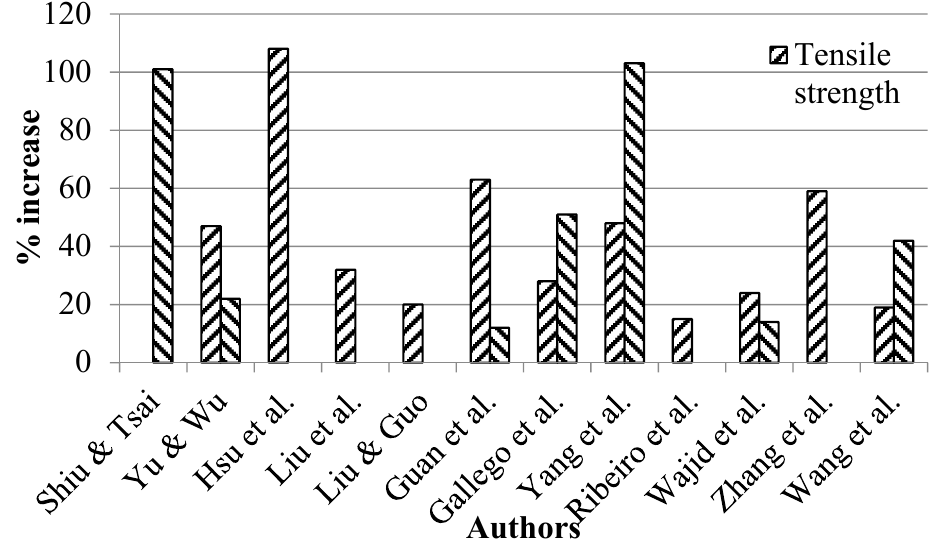
Figure 8. The % increase in tensile properties of epoxy/graphene nanocomposites [164,165,182–191].